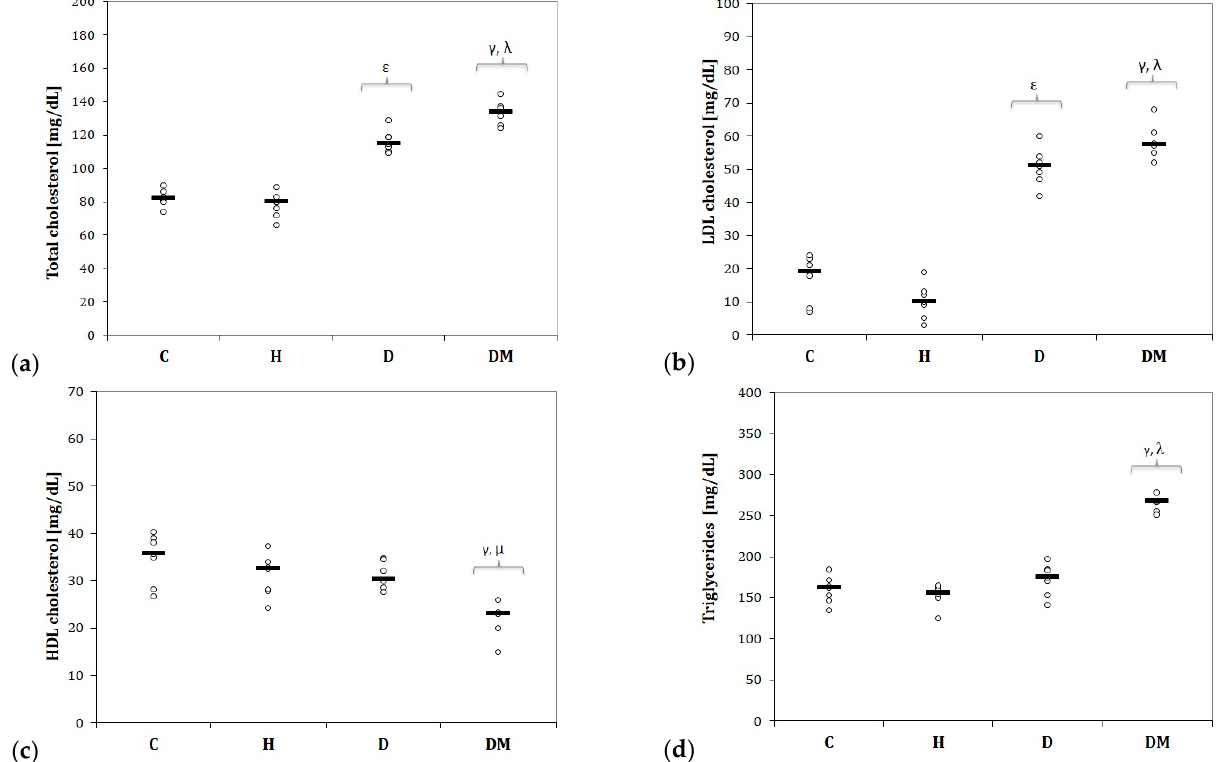
Figure 4. Variation of lipidic serum values by groups of: ( a ) Total cholesterol; ( b ) Low-density lipoprotein (LDL) cholesterol; ( c ) High-density lipoprotein (HDL) cholesterol; ( d ) Triglycerides. C = Control group, H = Hypertension group, D = Dyslipidemia group, DM = Type 1 Diabetes Mellitus group. The letter codes correspond to the Kruskal–Wallis post-hoc p -values: < 0.02, γ DM compared to C, < 0.025, ε D compared to H, < 0.003, λ DM compared to H, 0.046, µ DM compared to D.